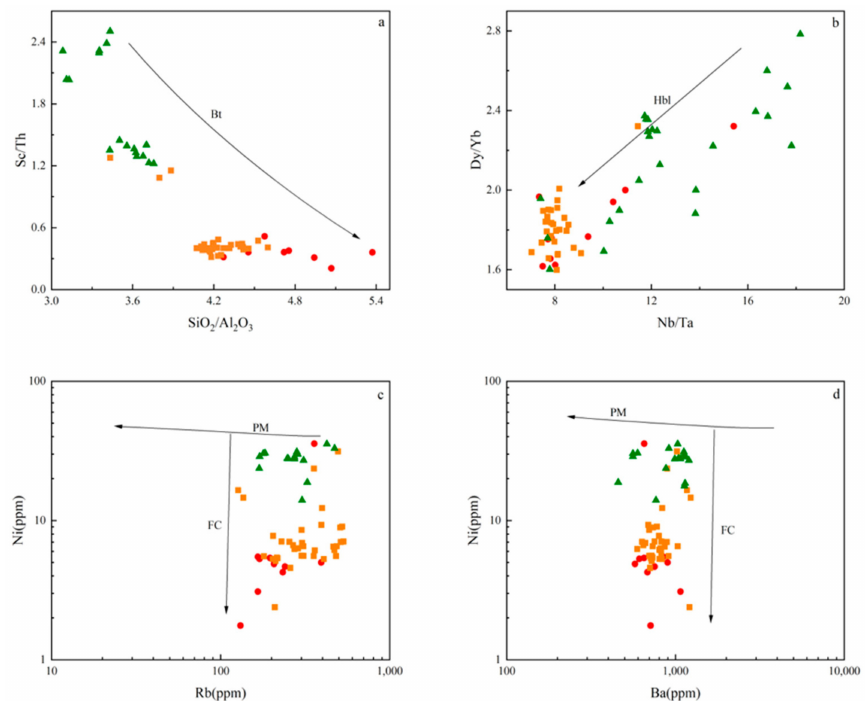
Figure 11. Whole rock element variation diagrams for volcanic rocks from the Shanghang Basin. ( a ) Sc / Th versus SiO 2 / Al 2 O 3 ; ( b ) Dy / Yb versus Nb / Ta; ( c ) Rb (incompatible element) versus Ni (compatible element); ( d ) Ba (incompatible element) versus Ni (compatible element). The symbols are the same as in Figure 7. PM: Partial melting; FC: Fractional